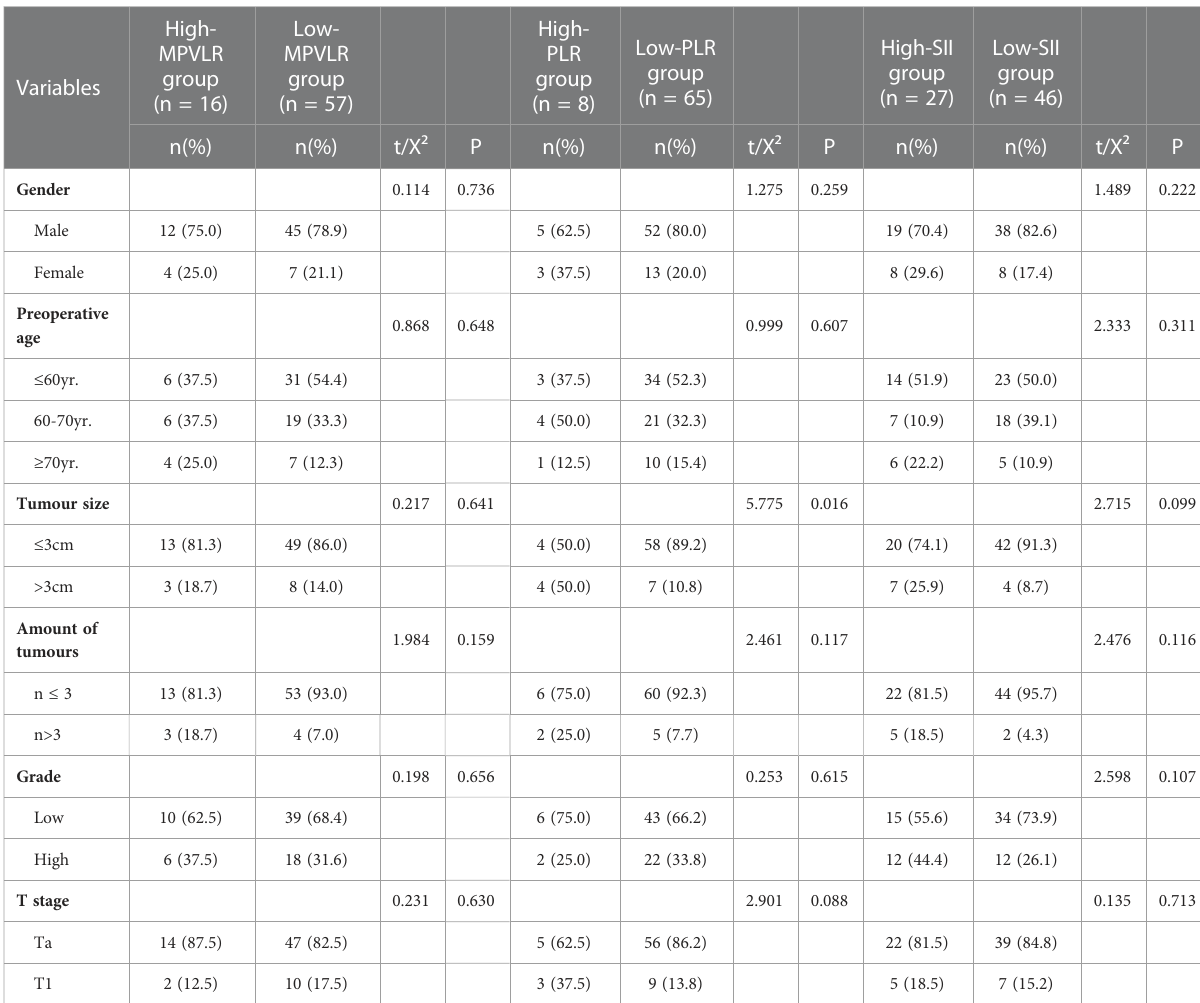
TABLE 3 Correlation between clinical data of the CHT group and PLR, SII, and MPVLR.